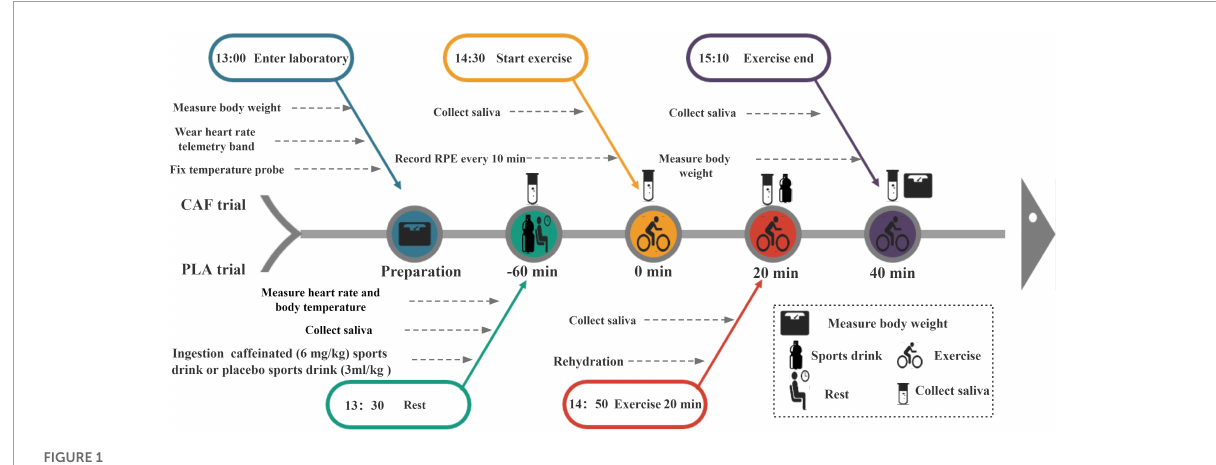
FIGURE1 Experimental procedure